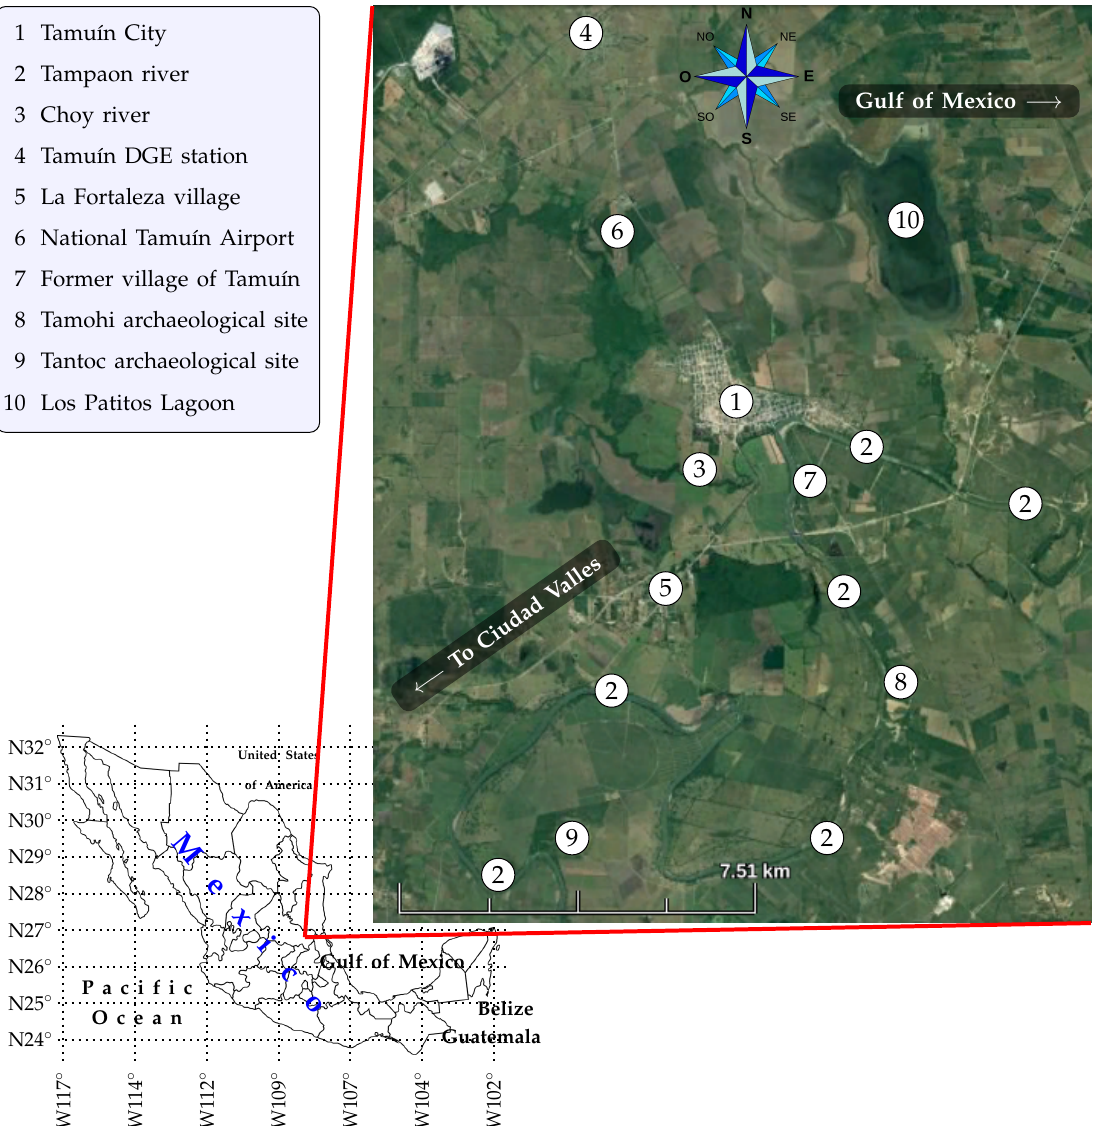
Figure 1. Location of the region under